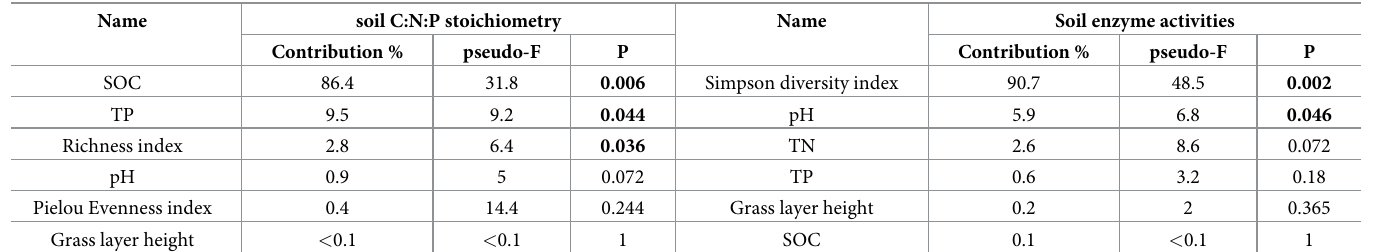
Table 4. Monte Carlo test at the soil stoichiometric and enzyme activity with environmental factors. Name soil C:N:P